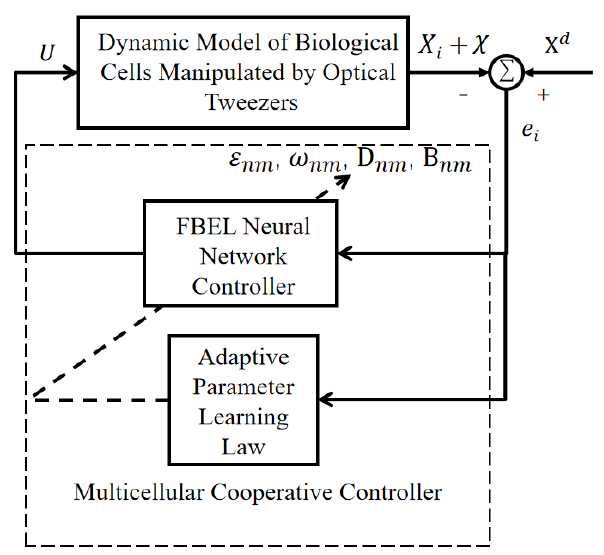
Figure 6. The structure of the multicellular cooperative controller based on the FBEL neural